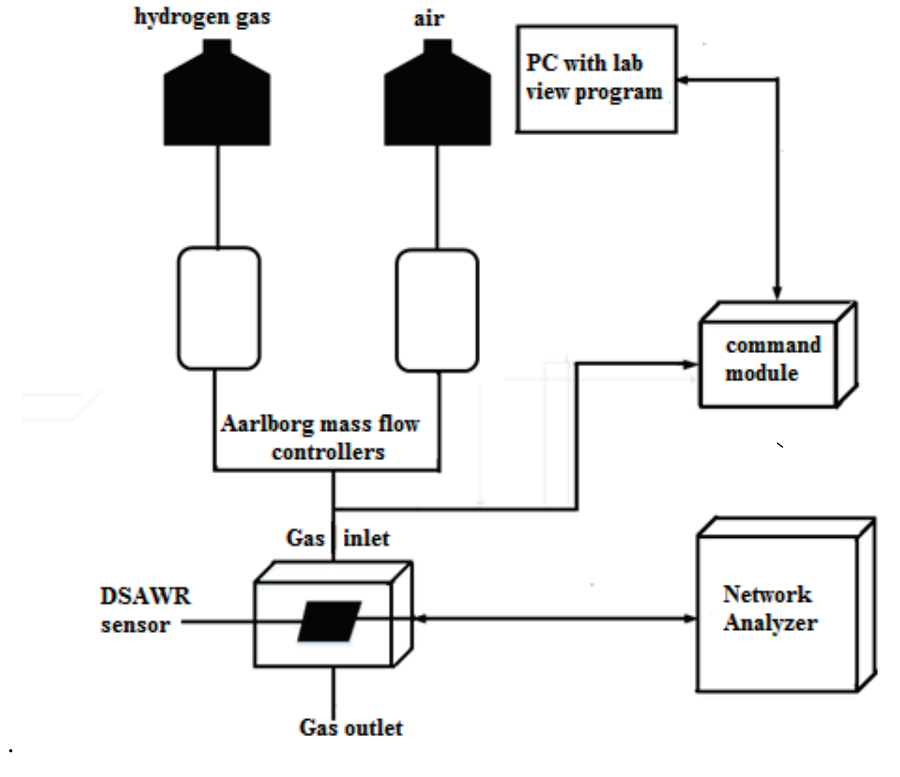
Figure 5. Gas sensing measurement set-up